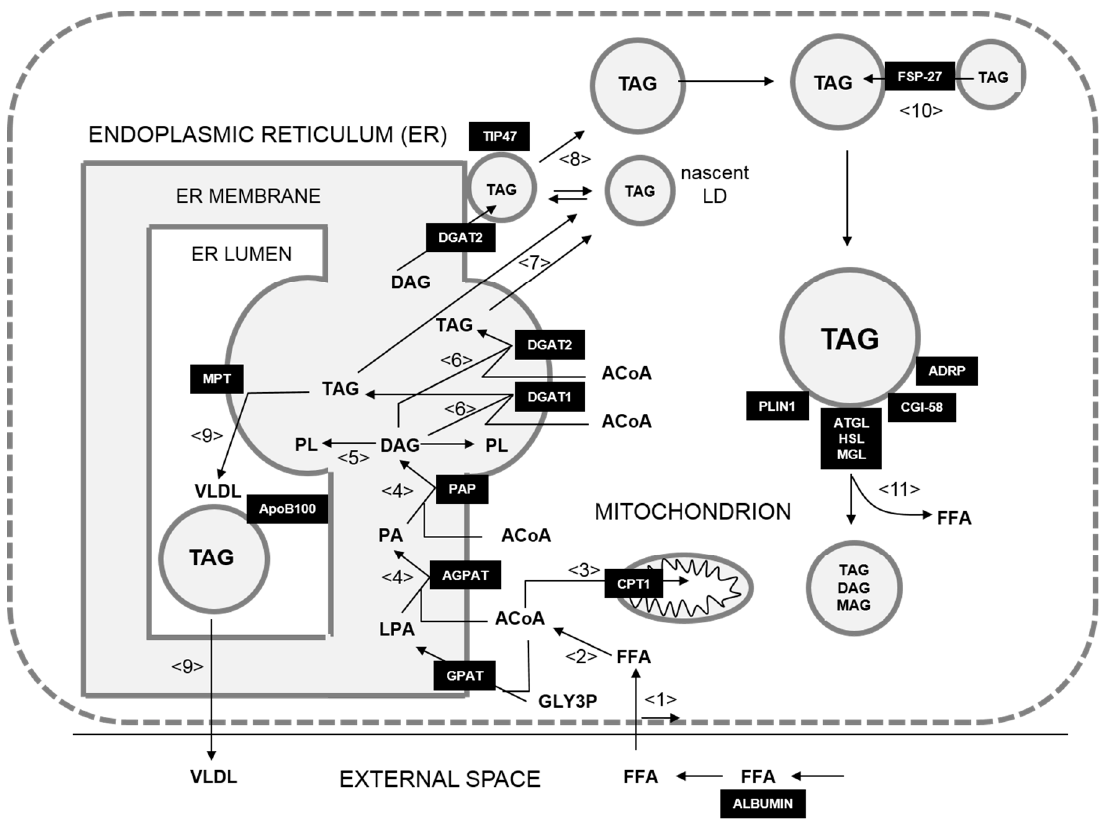
Figure 1. Schematic representation of the LD model. <1> Uptake of FFAs; <2> activation of FFAs; <3> uptake of FFAs into mitochondria for β -oxidation); <4> esterification of FFAs to LPA, PA, and